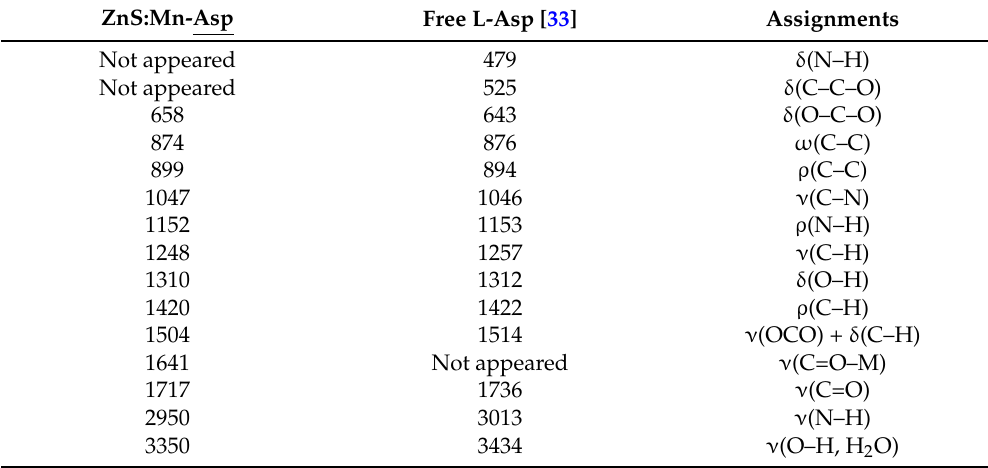
Table 1. FT-IR data and assignments of ZnS:Mn-Asp NCs. (units in cm ´ 1